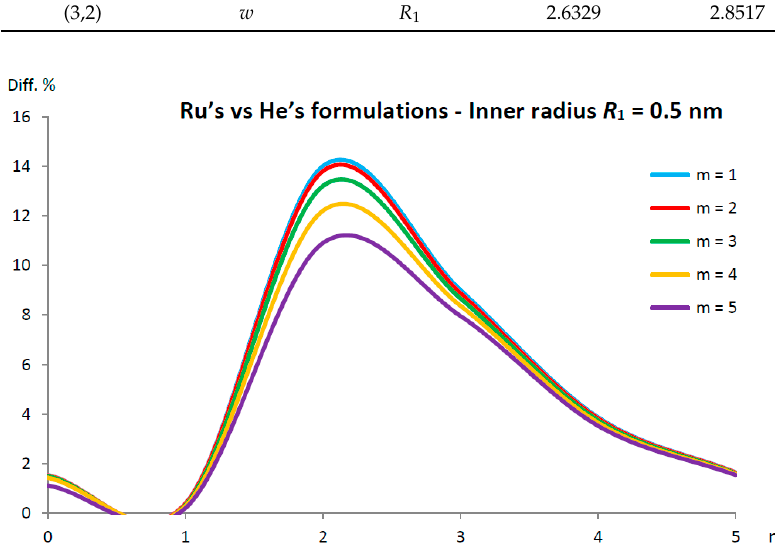
Figure 4. Percentage differences between the highest radial natural frequencies of the simply sup- ported DWCNT of Table 1 with inner radius R 1 = 0.5 nm and aspect ratio L / R 2 = 10 from Ru’s (38) and He’s (39) formulations. Donnell shell theory. Anisotropic elastic shell model. Number of longitudinal half-waves m . Number of circumferential waves n.